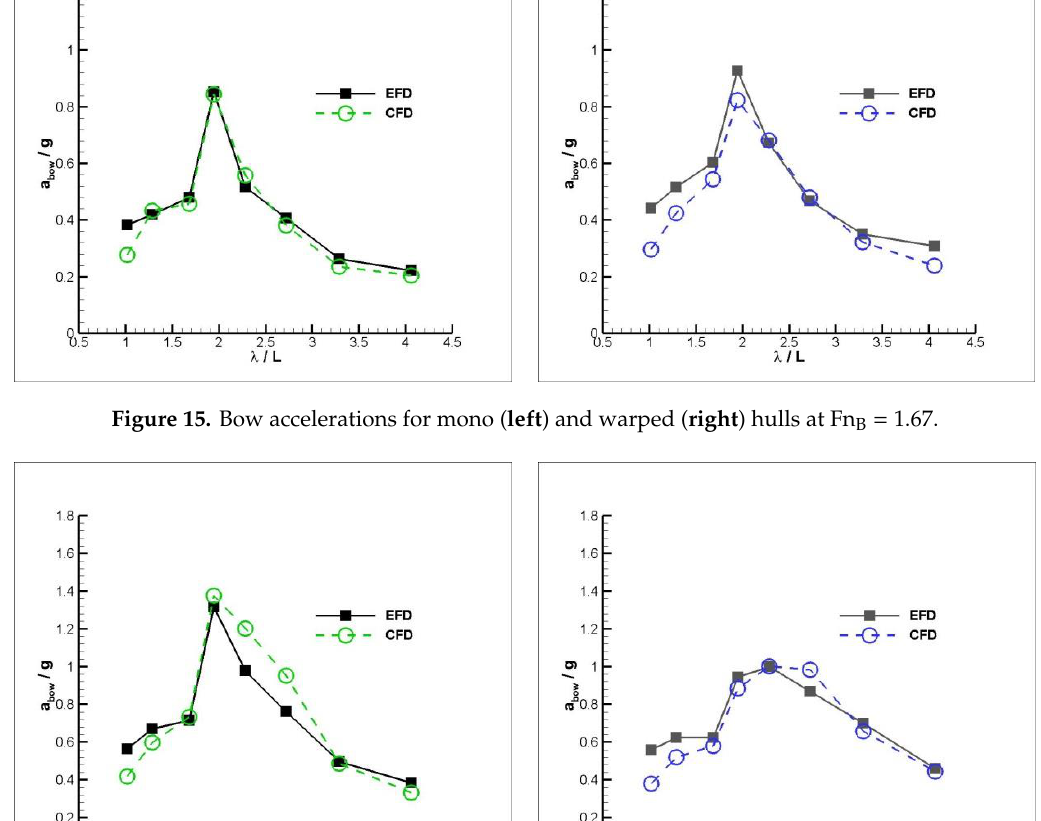
= 2.26. J. Mar. Sci. Eng. 2020 , 8 , x FOR PEER REVIEW B